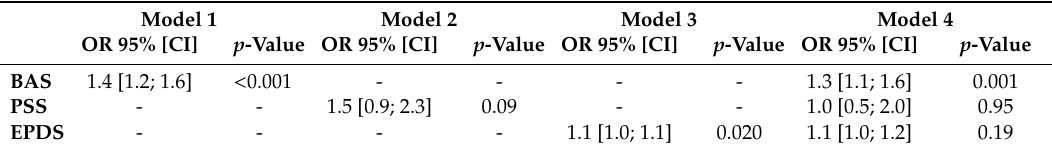
Table 3. Logistic regression models for the association between breastfeeding practices and maternal perceived stress, postpartum depression, and adherence of breastfeeding during the first 3 months of